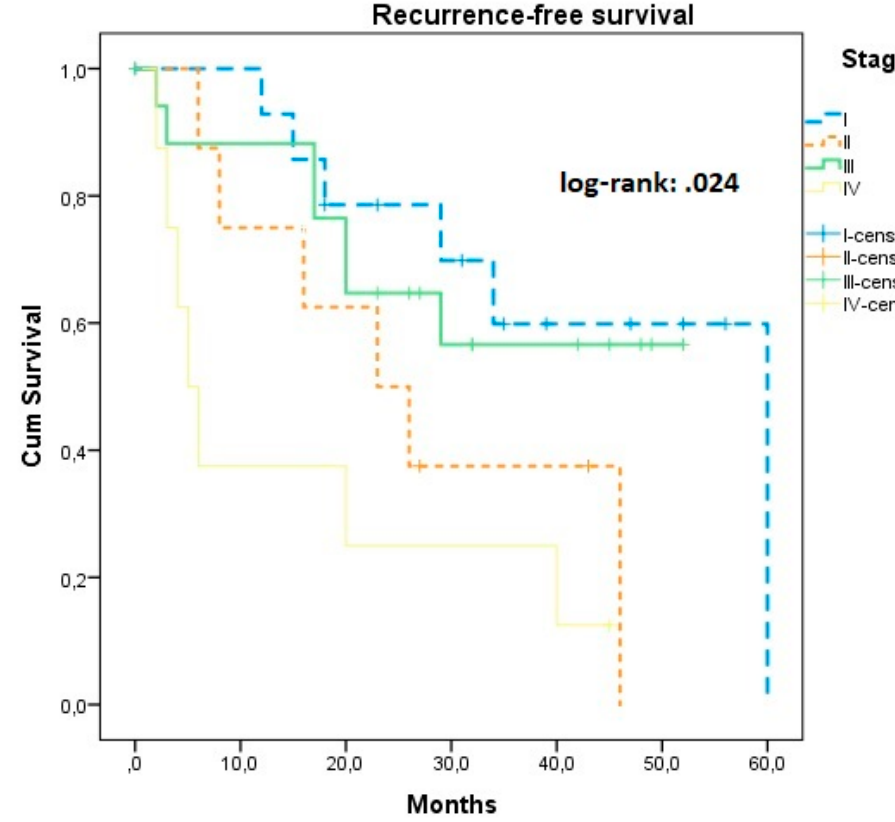
Figure 1. Kaplan–Meier plot of recurrence-free survival according to the stage of the disease. Separating cases with early-disease from those with advanced stage, we observed that the recurrence-free survival was shorter but non-statistically significant in patients with advanced-stage disease (30.91 (22.71, 39.13) vs. 37.10 months (27.70, 46.50), log-rank = 0.722). Similar results were obtained for overall survival (44.99 (34.20, 55.78) vs. 50.99 months (40.27, 61.72, log-rank = 0.490). Hazard ratios of recurrences and survival rates also did not reveal significant differences (PFS HR 1.51 (95% CI 0.63, 3.61) and OS HR 1.36 (0.56, 3.31)). Neither the presence of LVSI nor the use of adjuvant chemotherapy and/or radiotherapy influenced the impact of survival outcomes. This might be attributed to the stage of the disease, however, as all but one advanced-stage case received chemotherapy. Analysis of advanced-stage disease cases that received combination therapy with chemotherapy and radiotherapy compared to those that received only radiotherapy also revealed that differences in survival intervals were non-significant, although they were shorter in patients that received only chemotherapy (RFS 35.43 (27.44, 43.43) vs. 32.12 (22.44, 41.80), log-rank = 0.310 and OS 52.00 (41.42, 62.56) vs. 43.91 (32.45, 55.36) log-rank = 0.358). The risk of relapse, which was decreased in the combined group, was also compa- rable (HR 0.64 (95% CI 0.25, 1.66). Similar results were obtained for the risk of death from the disease (HR 0.65, 95% CI 0.28, 1.51). Following the omission of the three cases with residual tumors that did not accom- plish negative imaging results following adjuvant therapy, we observed that the recur- rence-free interval of cases with incomplete tumor debulking was significantly shorter compared to that of cases with complete tumor resection (Table 2). Similarly, the risk of relapse was 4 times increased. However, neither the risk of death nor the overall survival interval was significantly differentiated from cases that had complete tumor resection. As most of these cases involved tumors that involved the upper abdominal cavity, we per- formed the respective analysis and observed that while the recurrence-free survival was significantly shorter (11.60 (6, 28.51) vs. 38.81 months (31.97, 45.64), log-rank < 0.001), the overall survival of patients did not significantly differ (32.20 (8, 62.90) vs. 48.26 months (40.58, 55.94), log-rank = 0.576) (Figure 2). Following inspection of the Kaplan–Meier plot,